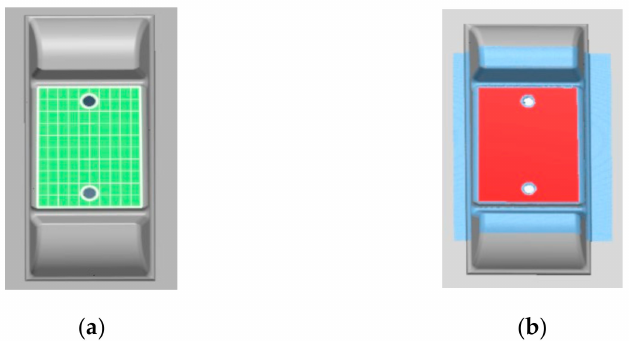
Figure 11. Characteristic creation and the extraction result: ( a ) Establishment of the characteristics of the supporting block plane; ( b ) The supporting block plane fitting extraction.